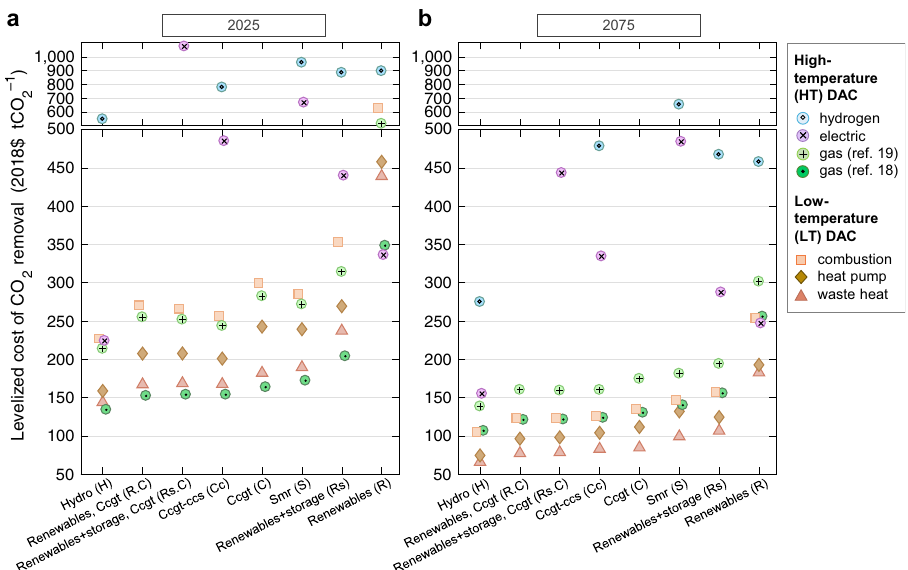
Fig. 5 The marginal levelized cost of net CO 2 removal (LCOR). Shown are years when the deployment program is nascent (2025; a ) and mature (2075; b ). Scenarios are shown by DAC con fi guration (markers) and electricity supply ( x -axis). For con fi gurations with energy storage, only the best-performing (lowest LCOR) scenario is plotted. For scenarios not shown, process CO 2 emissions exceed removals. Funding is from the club of democracies. The y -axis breaks and changes scaling beginning at 500 2018$ tCO 2 – 1 . (We show LCOR in 2025 and 2075 to highlight major trends; Supplementary Fig. 9 shows results over 2025 – 2100. Supplementary Figs. 10 and 11 further show LCOR by component